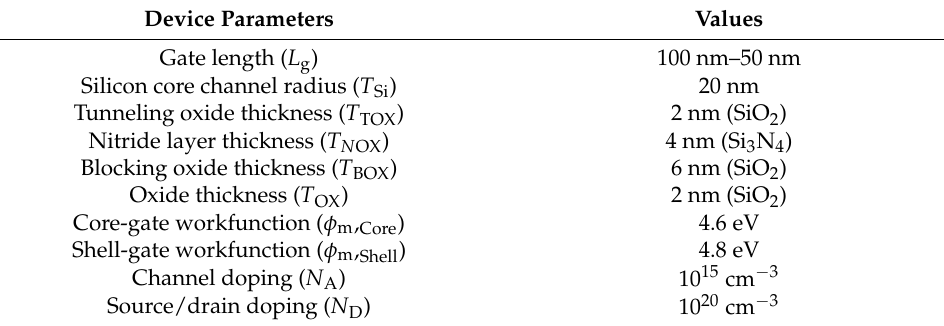
Table 1. Device specification for CSDG device as